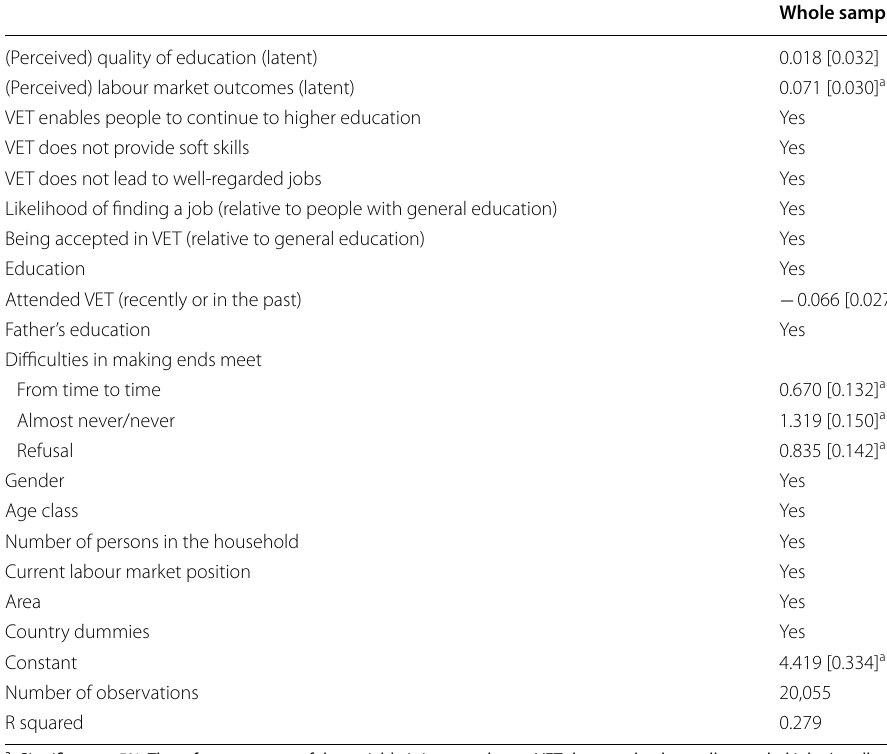
Table 4 Effect of VET on social positioning on the whole sample and by broad age group. Weighted data, OLS (clustered standard error in